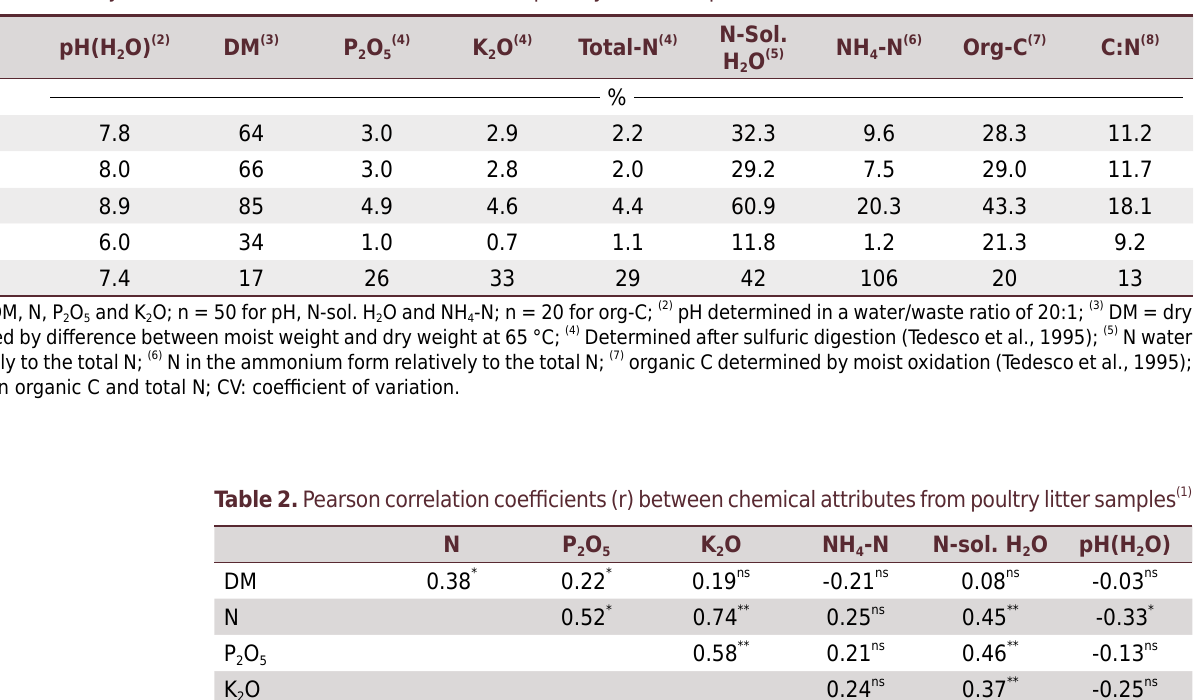
Table 1. Statistical analysis overview of chemical attributes from poultry litter samples (1)